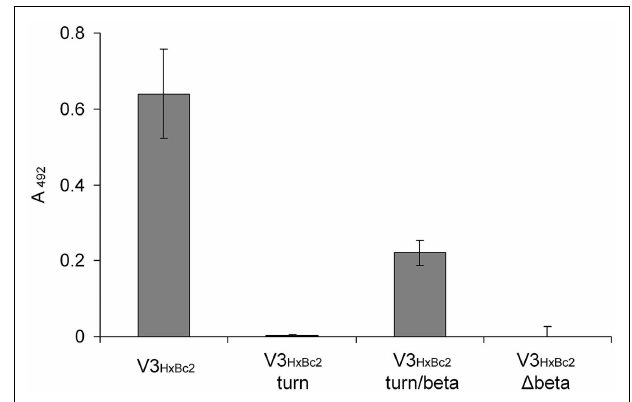
FIGURE 7 | Binding ofV3 HxBc2 and its truncated variants to the CXCR4 mimetic peptide CX4-M1 . See Section “Materials and Methods” (direct ELISA) for experimental detail. Error bars present deviations from the mean.